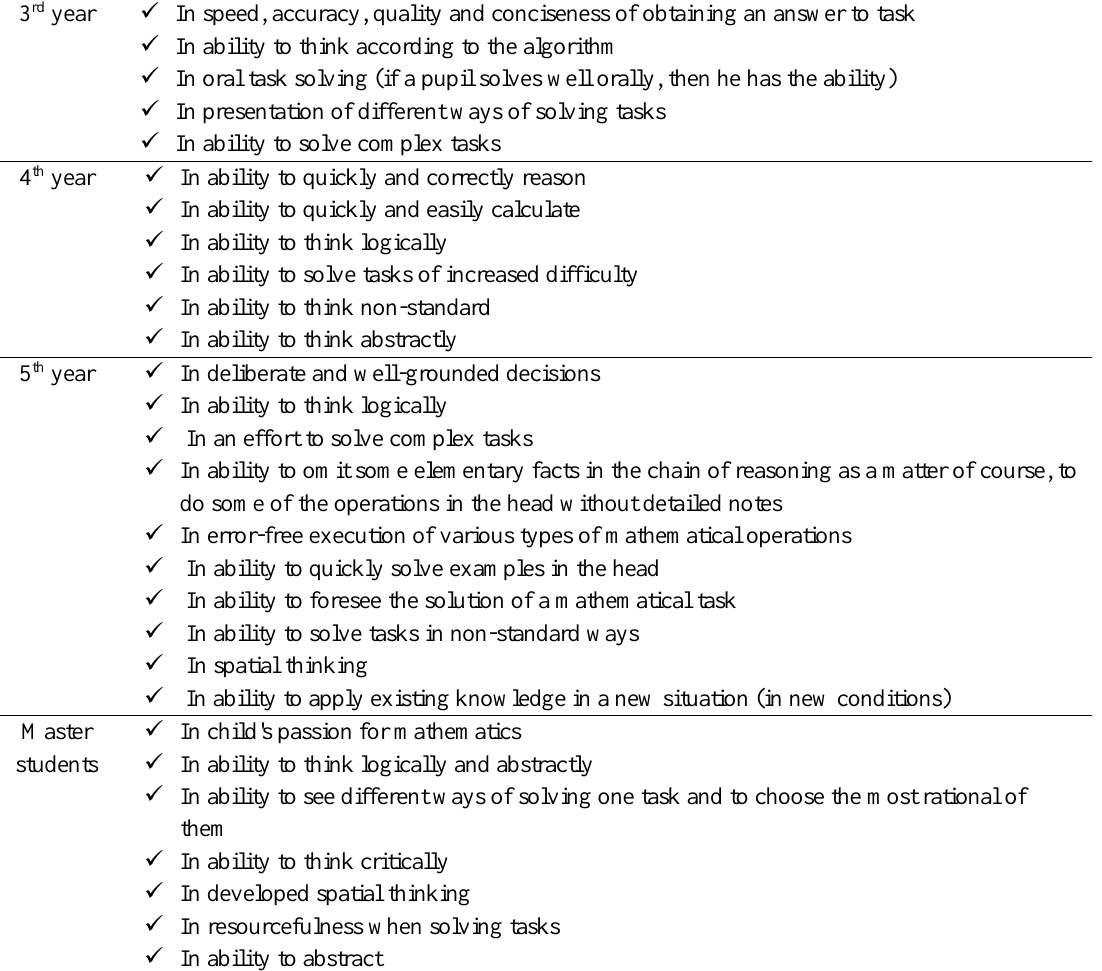
Table 6. Students 'answers to the question “How did your teacher develop your math abilities?” 3 rd year ✓ Solving Olympiad